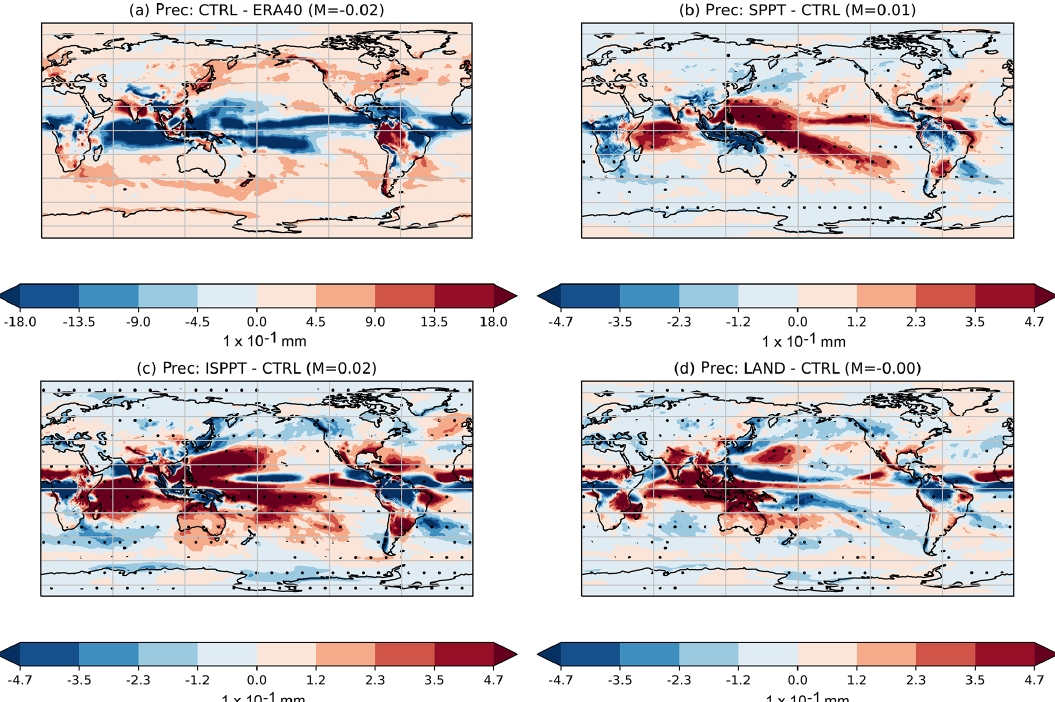
Figure 3. Mean differences in precipitation between the (a) CTRL and ERA40, (b) SPPT and CTRL, (c) ISPPT and CTRL, and (d) LAND and CTRL. Stippling indicates regions where the difference is statistically significant to the 95% confidence interval, as measured by a two-tailed t test. In each panel, M denotes the mean of the difference. Note the difference in the scales between (a) and (b, c, d)